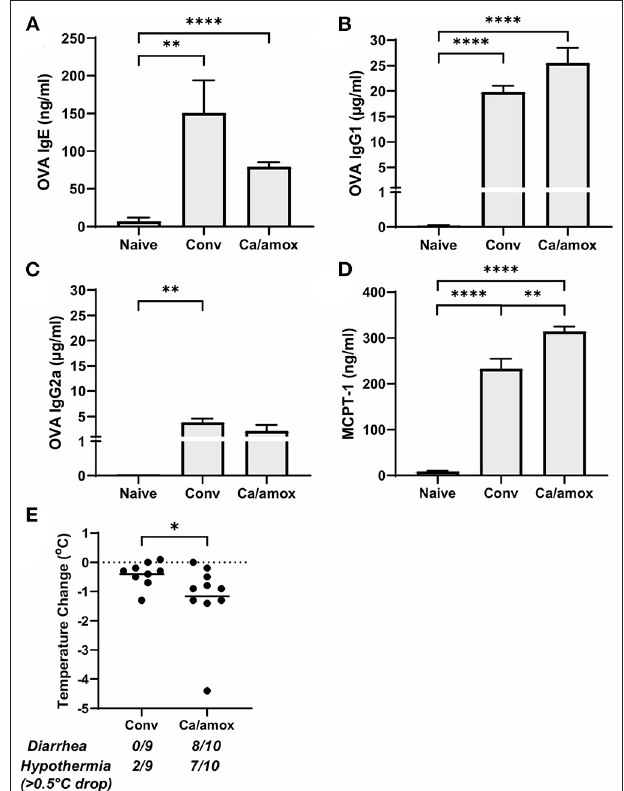
FIGURE 3 | Systemic anaphylaxis indicators measured post-oral antigen exposure in conventional (Conv) and microbiota disrupted (Ca/amox) Balb/cJ mice. Serum antibody and anaphylaxis mediators were collected after challenge seven on D42 and (A) OVA-specific IgE (B) OVA-specific IgG1, (C) OVA-specific IgG2a, and (D) MCPT-1 were measured by ELISA. (E) The average body temperature drop between 15 and 90min and the incidence of diarrhea were taken immediately after OVA challenge seven on D42. Shown below the average temperature drop is the number of mice with diarrhea or hypothermia defined as > 0.5 ◦ C drop out of the total number per group. A single dot represents one mouse and a bar represents the mean ± SEM for the corresponding group: n = 9 to 10 mice. P -values were determined with a Student’s t- test. Statistical significance is * P < 0.05, ** P < 0.01, and **** P <